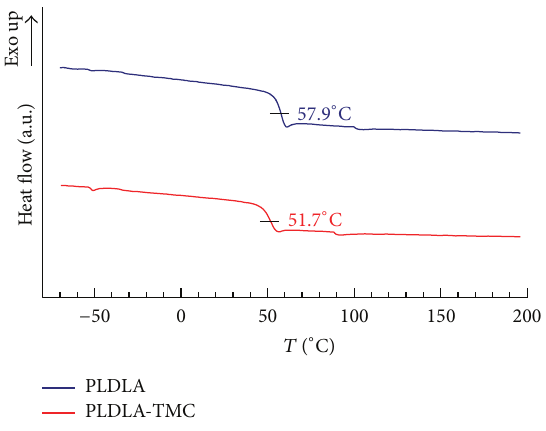
Figure 5: DSC thermograms showing the glass transition tempera- ture of PLDLA and PLDLA-TMC scaffolds.